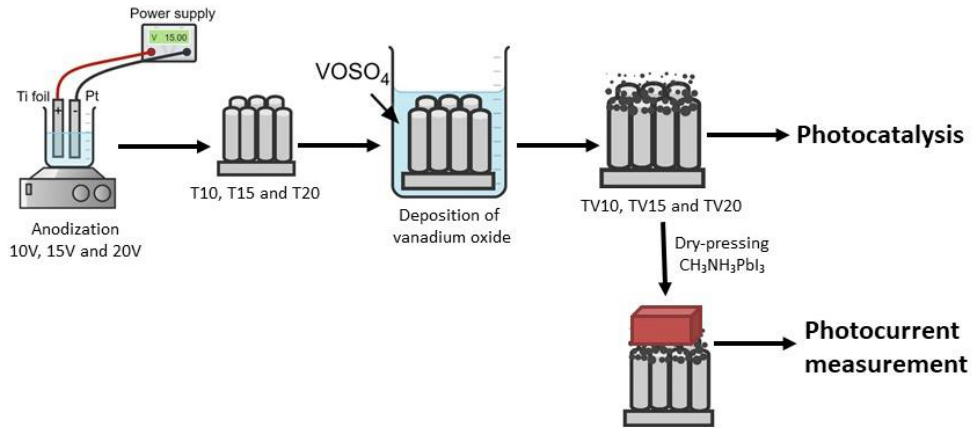
Figure 8. Schema of the method of synthesis of TiO 2 nanotubes, deposition of vanadium oxide and heterojunction formation with monocrystal CH 3 NH 3 PbI 3 .